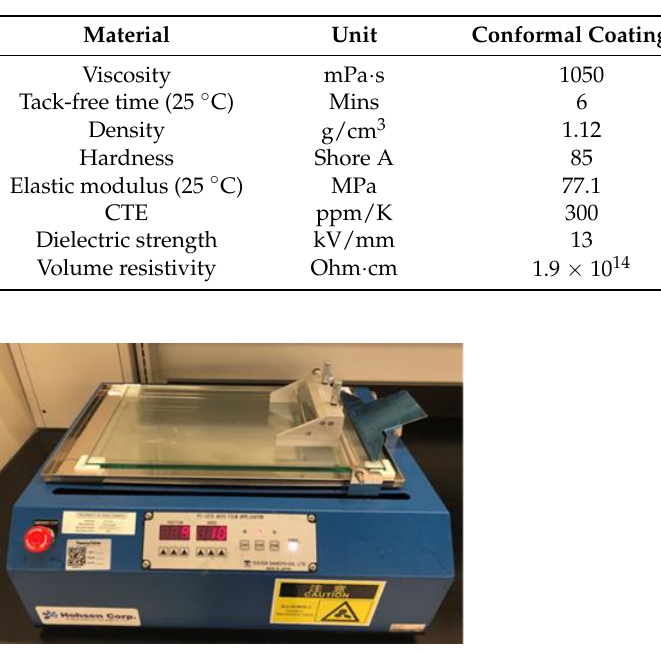
Table 1. Conformal coating material properties.